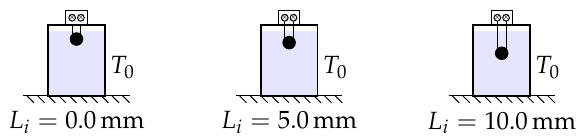
Figure 13. Different immersion lengths L i in glycerol.